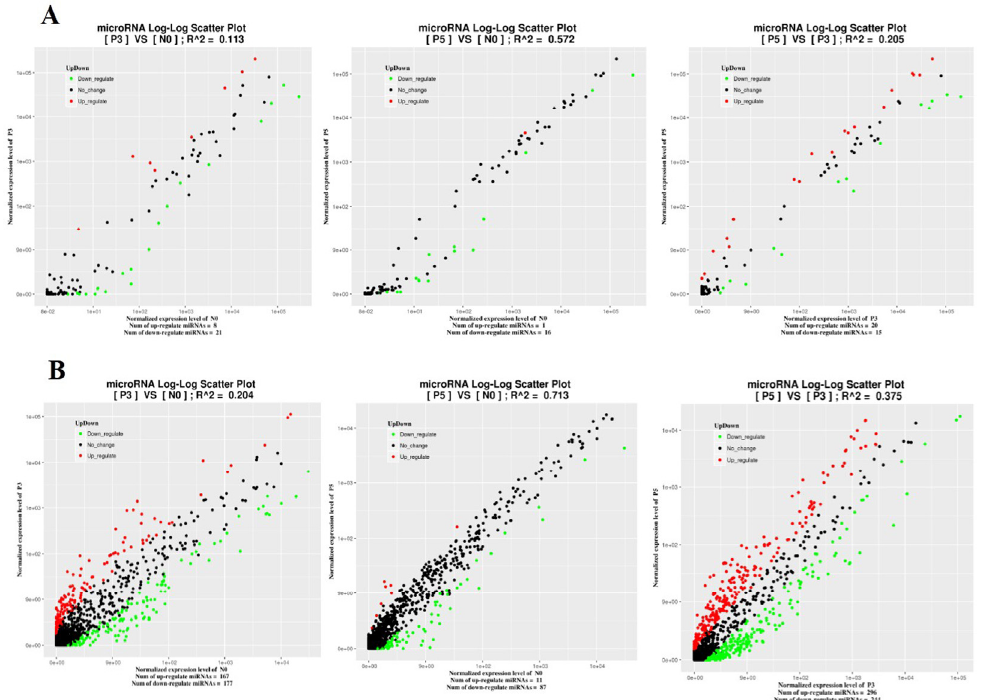
Figure 2. Comparison of expression levels of known miRNAs ( A ) and novel miRNAs ( B ) in PPR vaccine virus-inoculated at 3 dpi (P3) or 5 dpi (P5) and mock-inoculated (N0) sheep PBMC. X and y axes represent the expression levels of the miRNAs of the two groups. The red points represent miRNAs with fold changes greater than 2; the blue points represent miRNAs with fold changes between 0.5 and 2; the green points represent miRNAs with fold changes less than